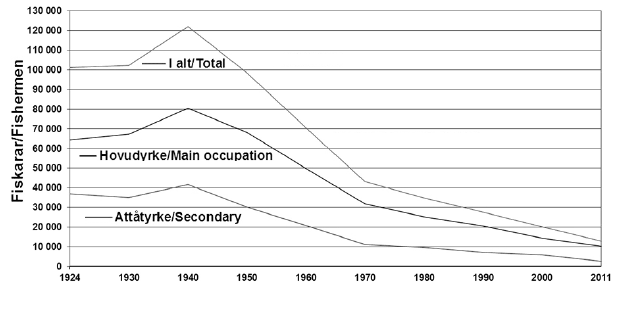
Fig. 2. Changes in numbers of fish harvesters in northern Norway from 1924 to 2011. Source: Fiskerdirektoratet (2012 a: